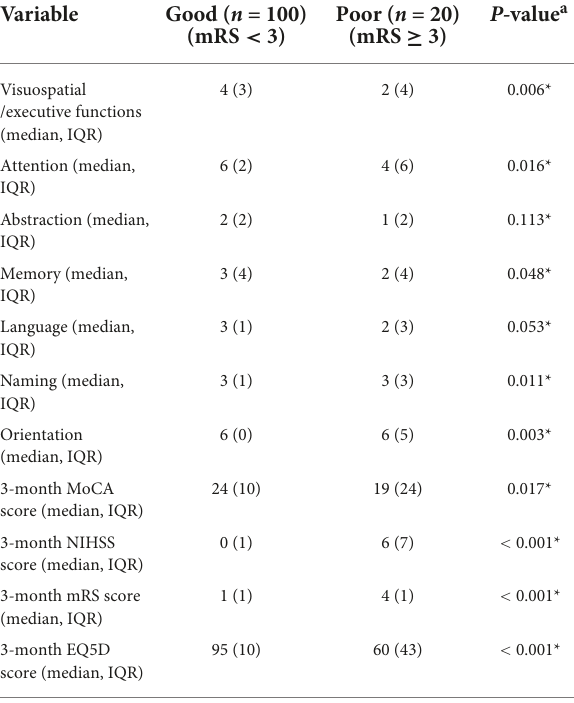
TABLE 4 The 3-month score according to the functional